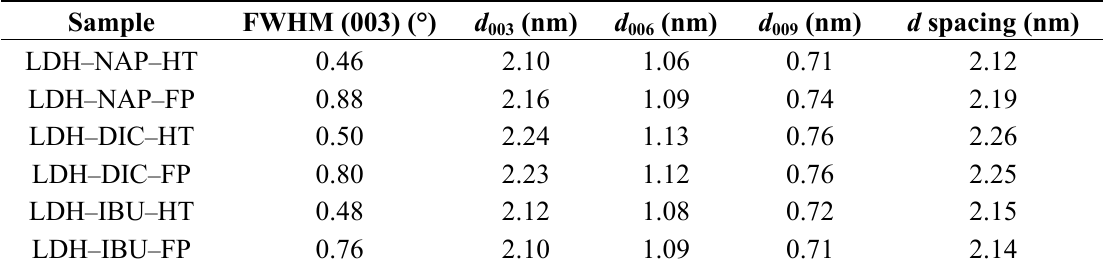
Table 2. Interlayer spacing and full width at half-maximum (FWHM)